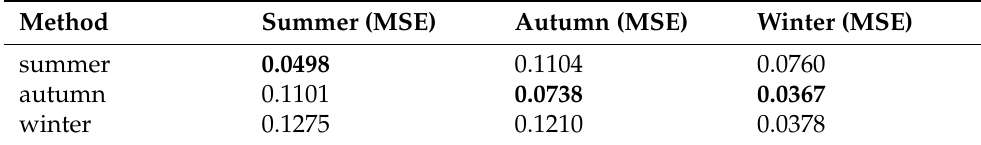
Table 2. Generalization capabilities of the trained neural network models.